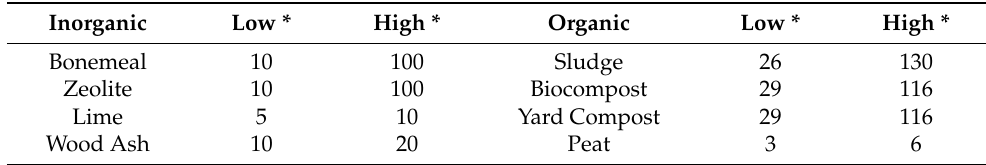
Table 1. The application rates of soil amendments to immobilize Pb. Inorganic Low * High * Organic Low * High * Bonemeal 10 100 Sludge